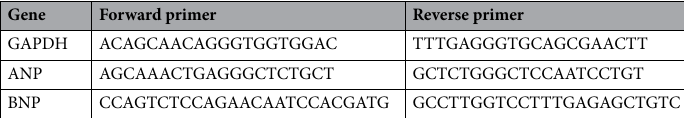
Table 1. Real-time PCR primer sequences.